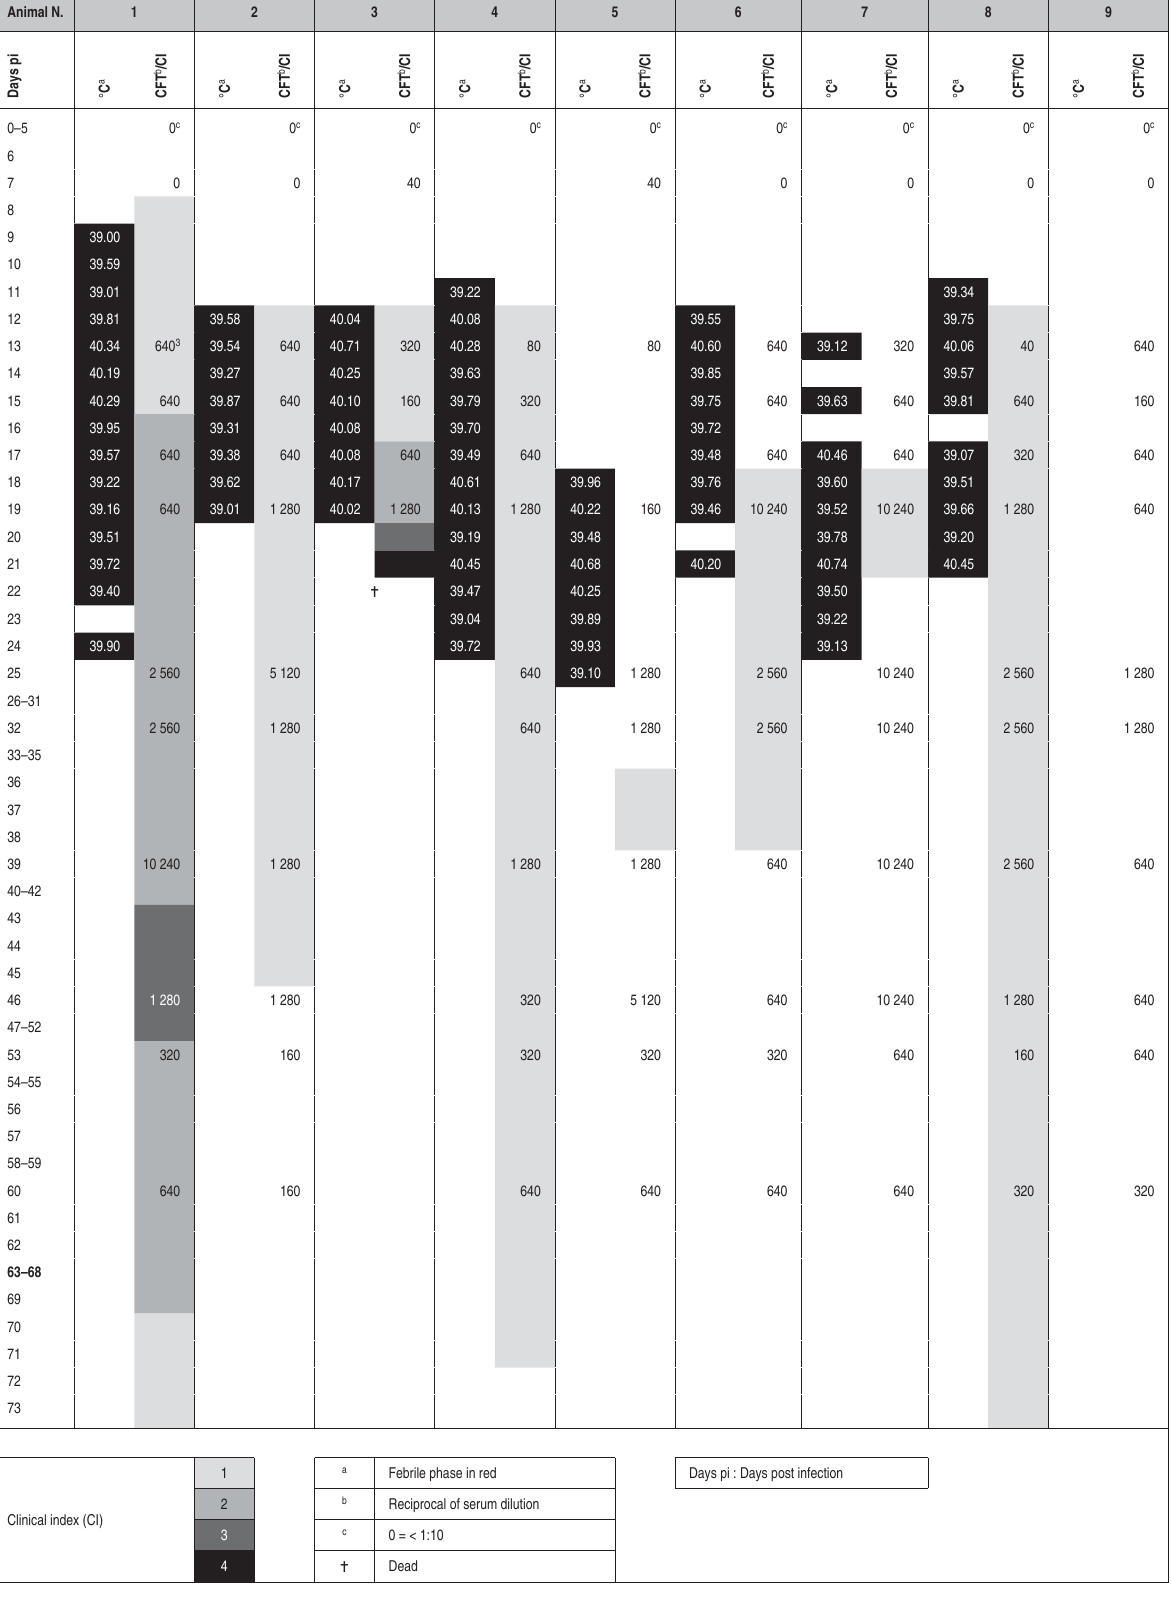
TABLE 2 Events following infection of cattle by intubation Animal